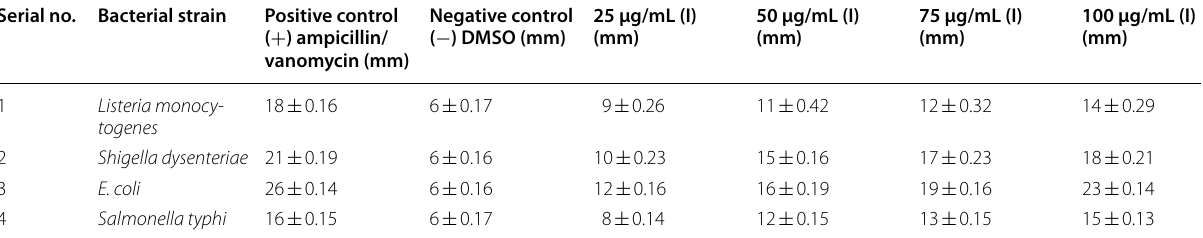
Table 1 Antibacterial activity of T. purpureogenus AgNPs against (1) Listeria monocytogenes (2) Shigella dysenteriae (3) E. coli (4) Salmonella typhi Serial no. Bacterial